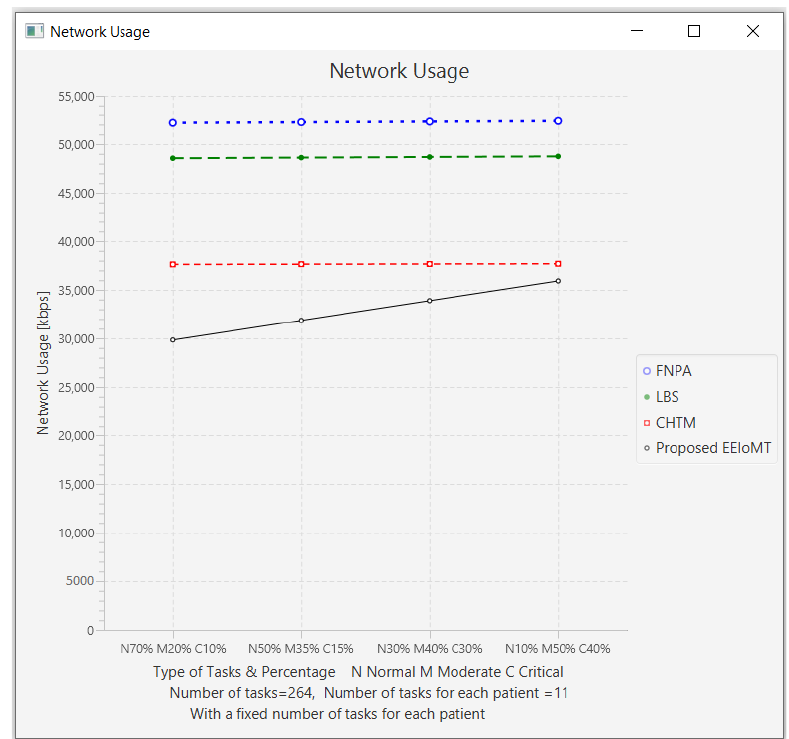
Figure 25. Average energy consumption comparison when changing the percentage of each type of task.